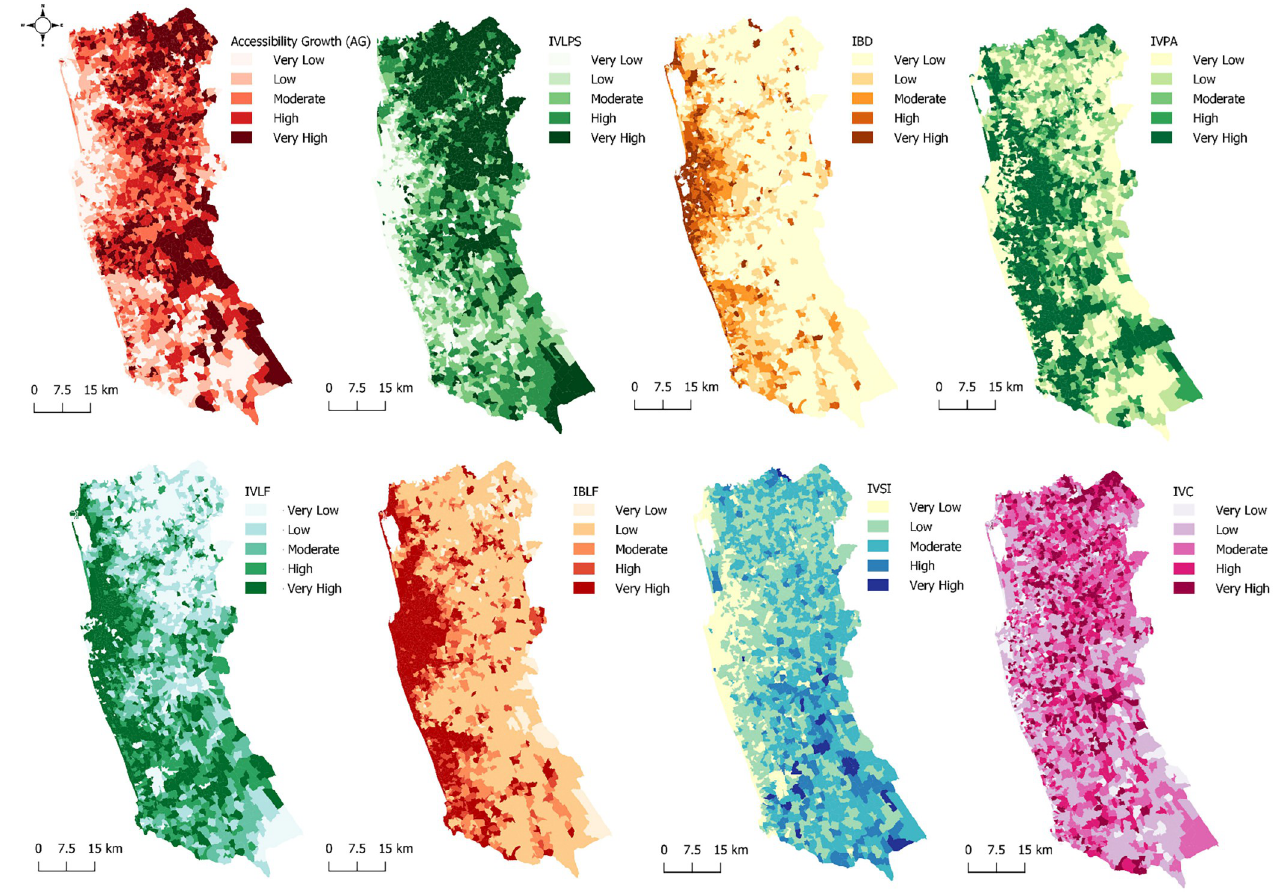
Fig 4. Spatial distribution of